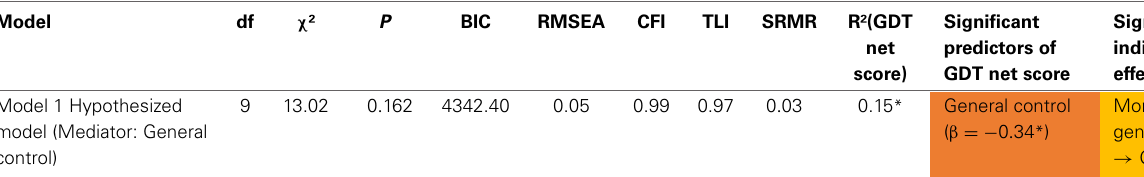
Table 3 | The fit indices of the seven main